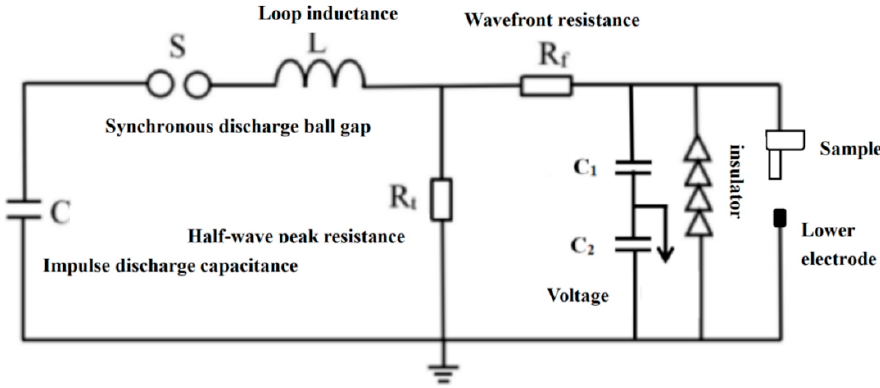
Figure 8. Lightning impulse discharge equivalent test circuit.